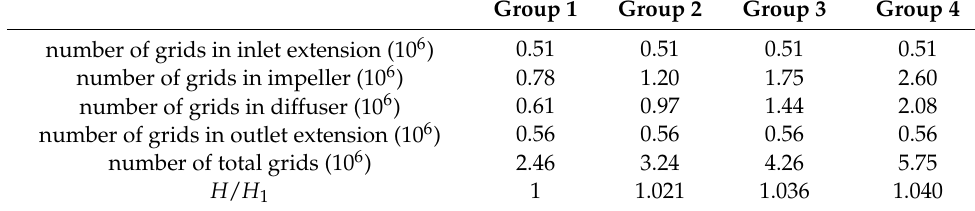
Table 2. Mesh independence verification.